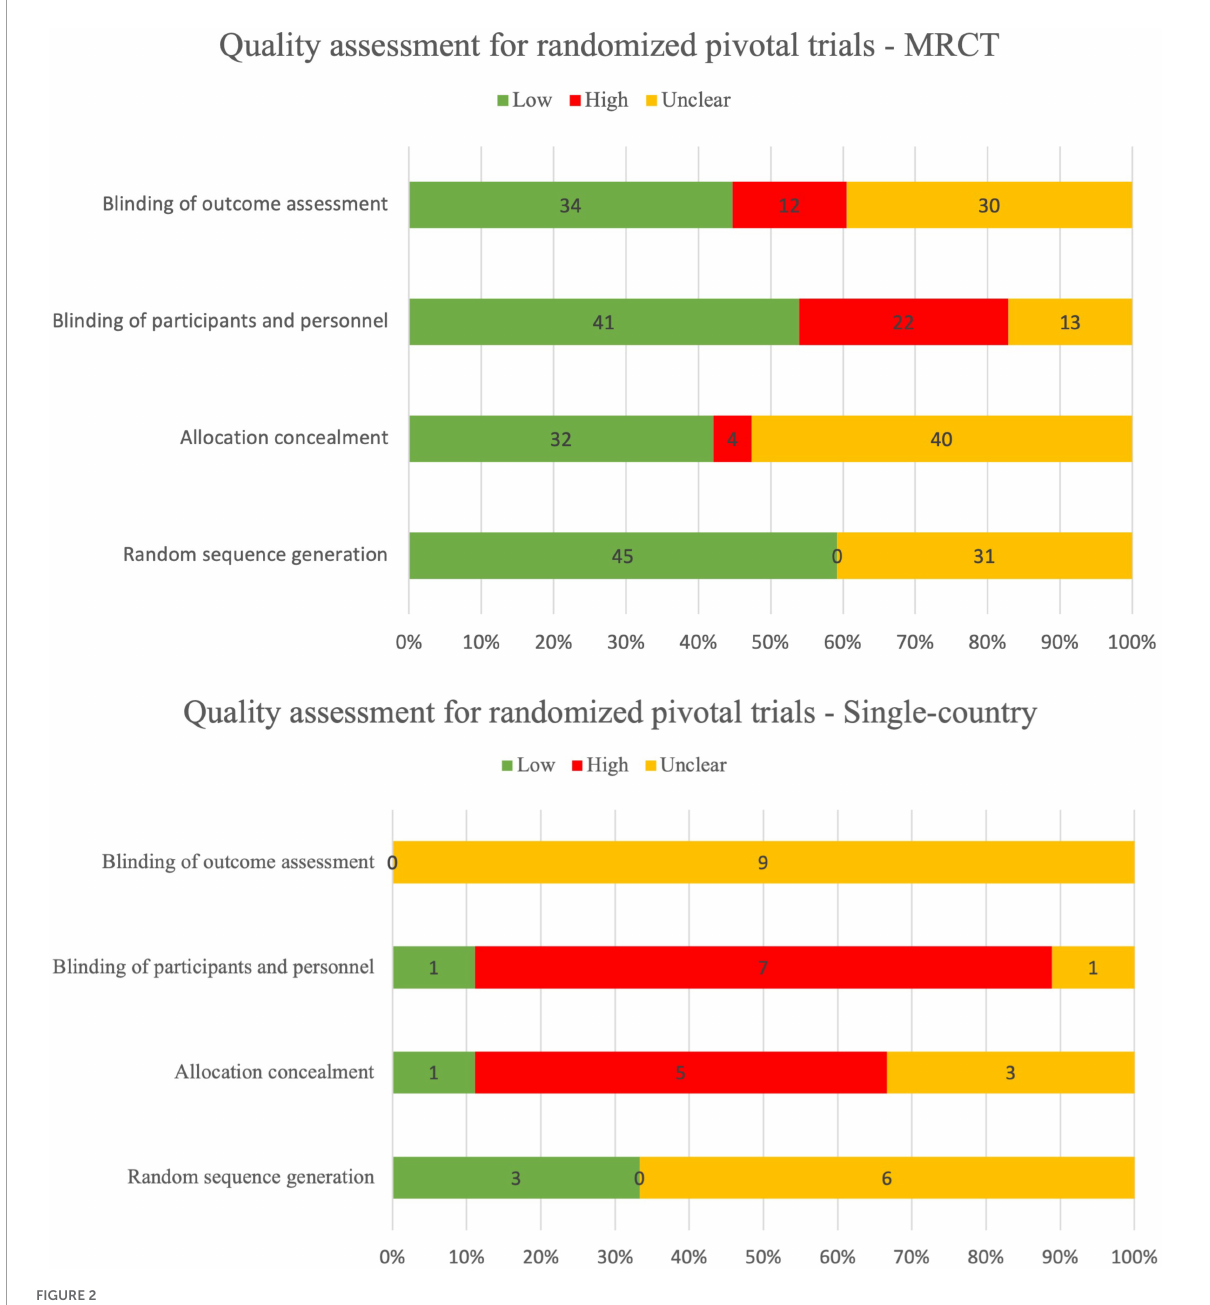
FIGURE2 Quality assessment for randomized pivotal trials using RoB 2.